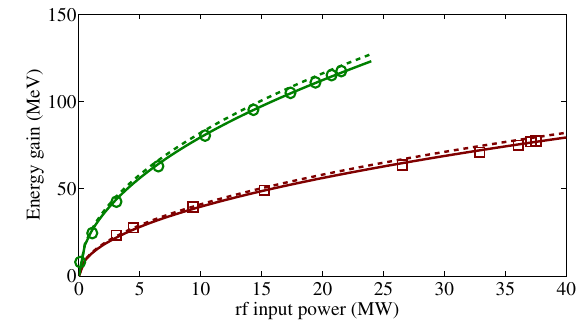
FIG. 20. Measured beam energy gains per accelerating struc- ture as a function of the rf input power for the FINSB02 (red squares, one structure) and FINSB 03 = 04 (green circles, two structures) rf stations. The solid lines of the corresponding colors represent square-root fits to the data, the dashed lines show the respective design